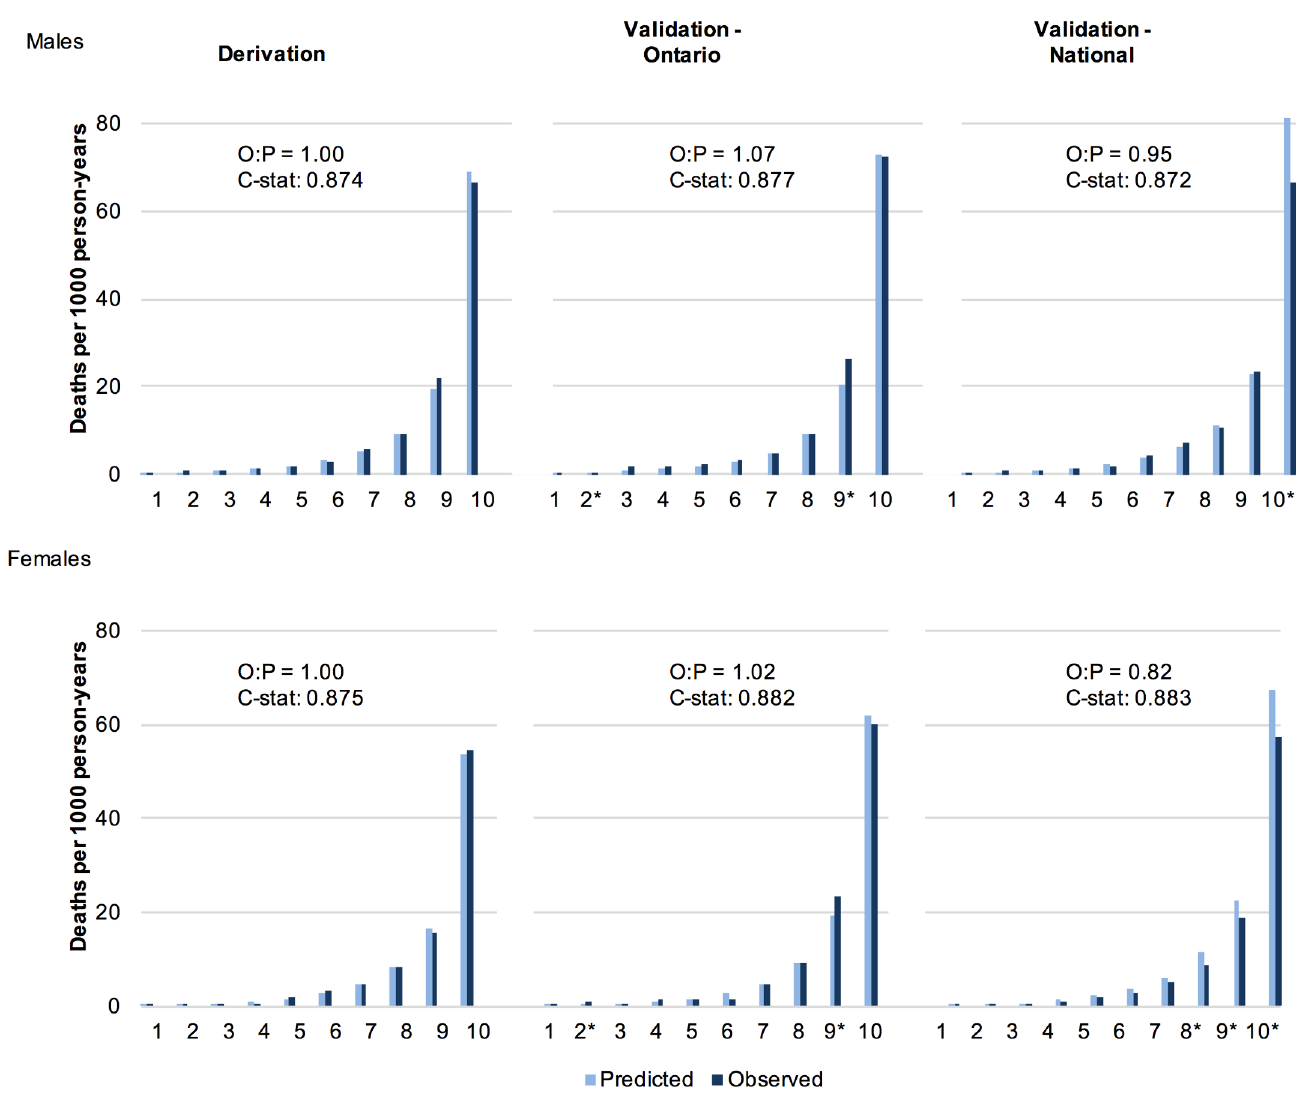
Fig 1. Observed and predicted 5 y risk of death by risk decile for males and females. Predicted deaths from full MPoRT model (incorporating age, health behaviours, sociodemographic, and disease indicators) * Statistically significant difference. Abbreviations: O = observed; P = predicted; C- stat =